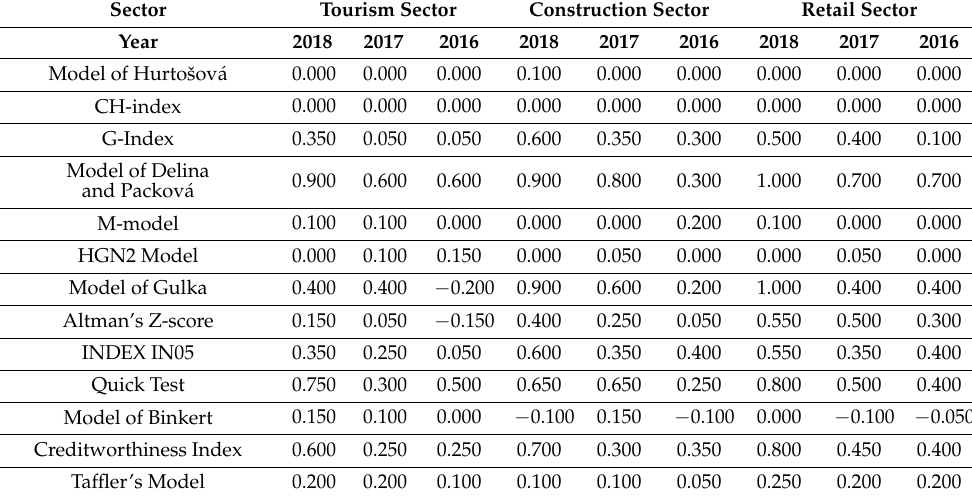
Table A3. Results of testing models for each sector using the Accuracy Adj.